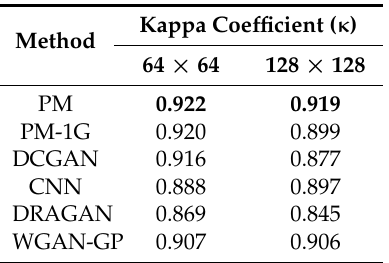
Table 4. The Cohen’s kappa coefficient ( κ ) of PM, PM-1G, DCGAN, supervised CNN, DRAGAN, and WGAN-GP trained by 600 labeled